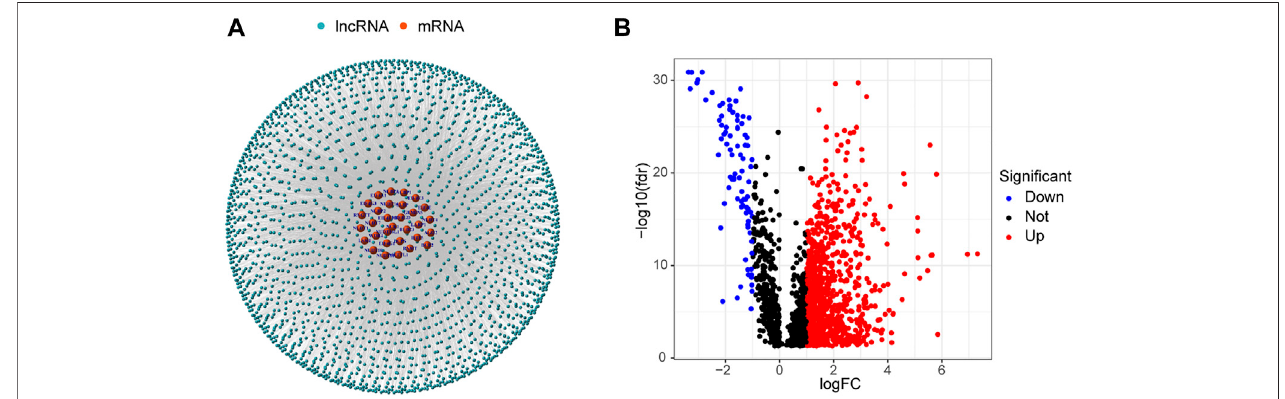
FIGURE 2 | Identi fi cation of m7G-related lncRNAs in LUAD patients. (A) Co-expression network of m7G-related lncRNAs and mRNAs. (B) 990 differentially expressed